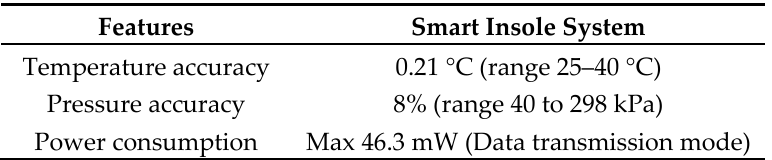
Table 1. Main features of the developed smart